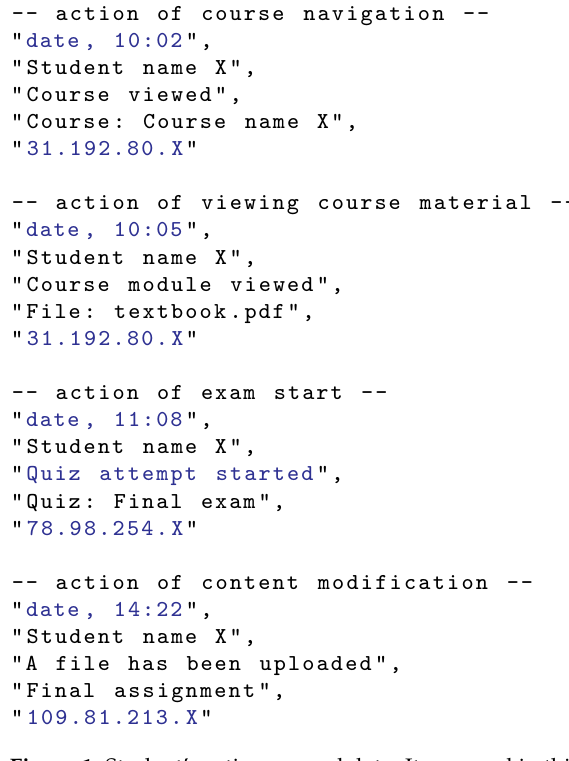
Figure 1. Student’s action general data. Items used in this work are